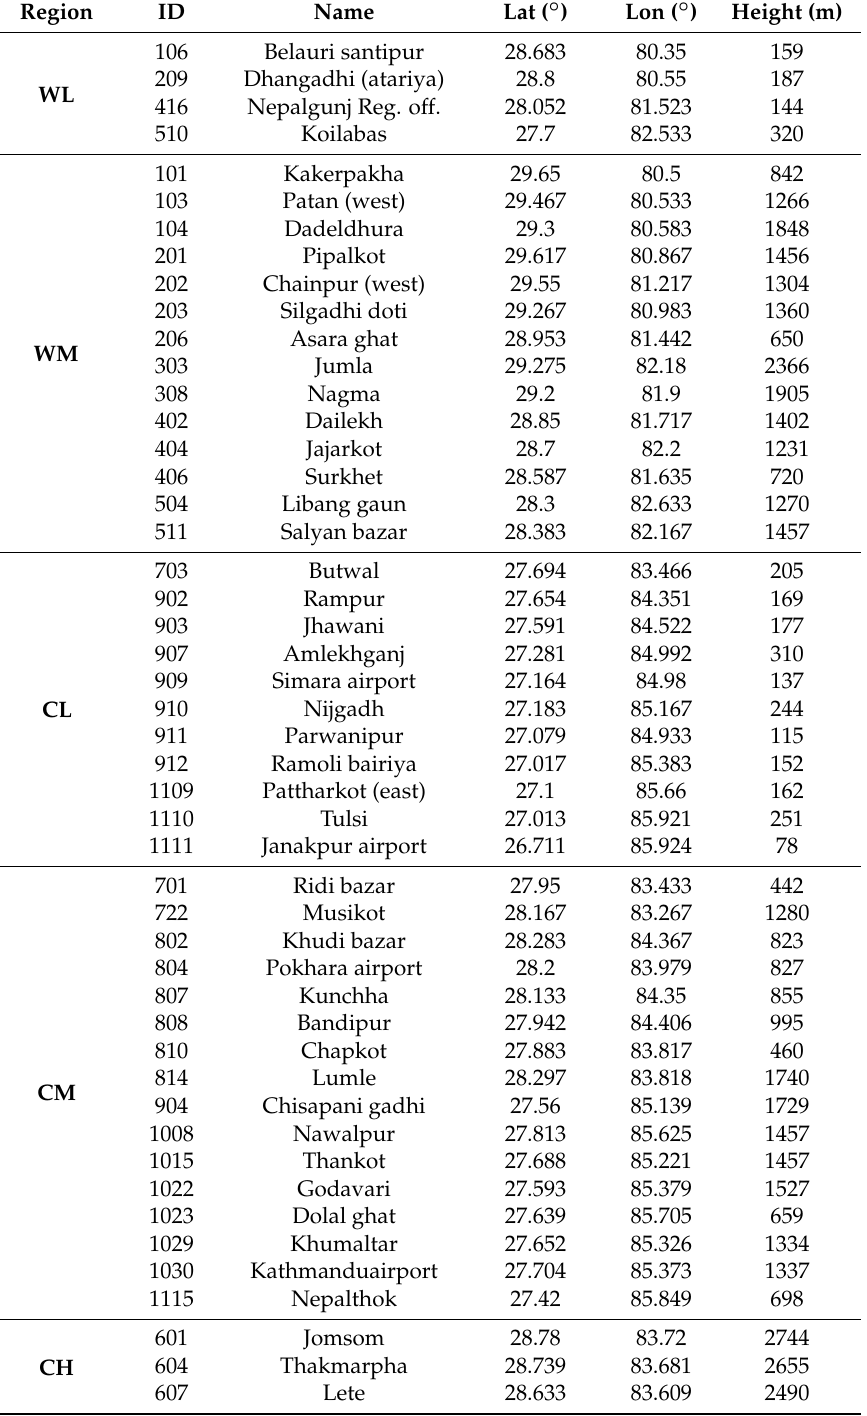
Table 1. List of meteorological